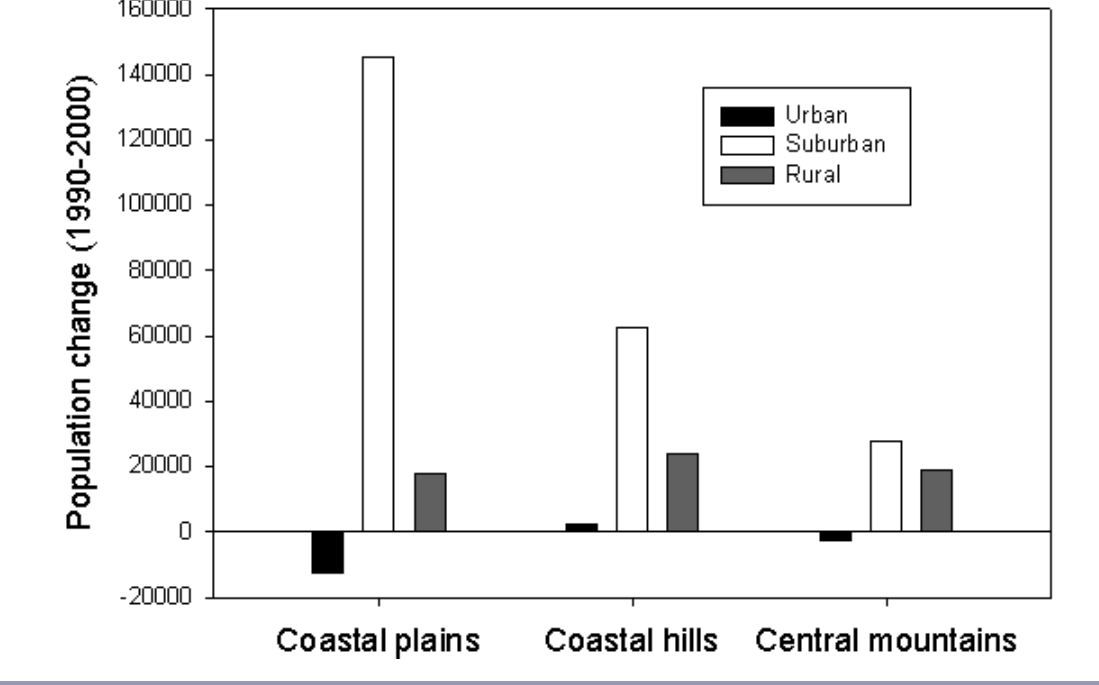
Fig. 2. Population change between 1990 and 2000 for the three barrio types within the three elevation